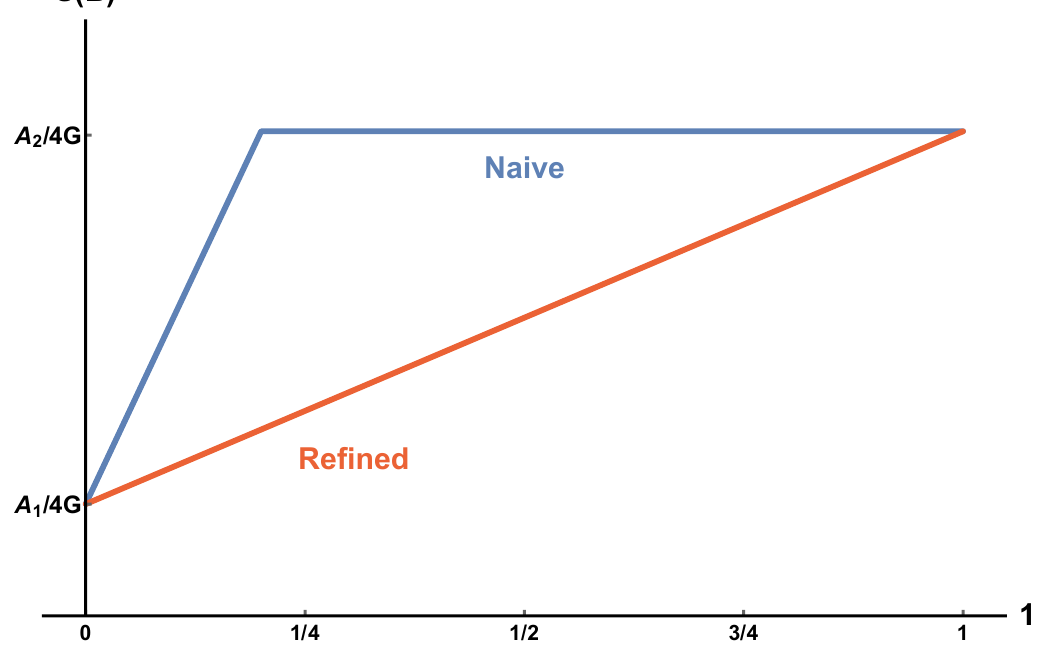
Figure 2 . Comparison of the naïve QES entropy to the correct, “refined” answer, for the state (1.4) in the setup of figure 1. While the slope of the refined answer is controlled by ( A slope of the naïve answer is controlled by S larger than the refined one by an O (1 /G )